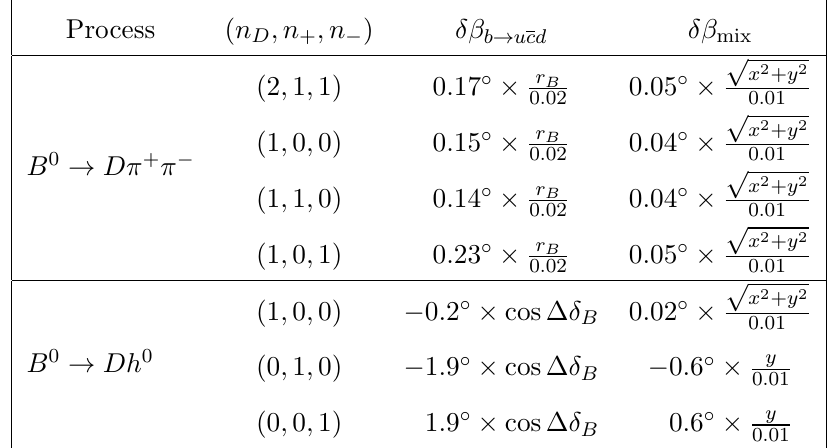
Table 5 . Estimates for the angle (cid:12) measurement bias due to the neglect of b column) and charm mixing (4 th column). The second column shows the D 0 decays combination used in the (cid:12)t: n D ; n + ; n (cid:0) are relative fractions of D 0 decays yields,